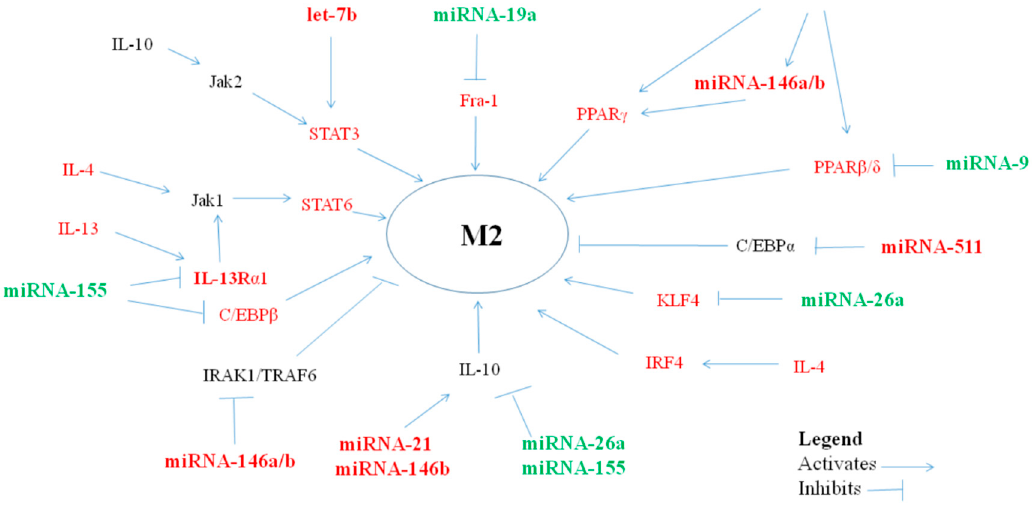
Figure 2. miRNAs, via their targets, influence anti-inflammatory M2-macrophage polarization.